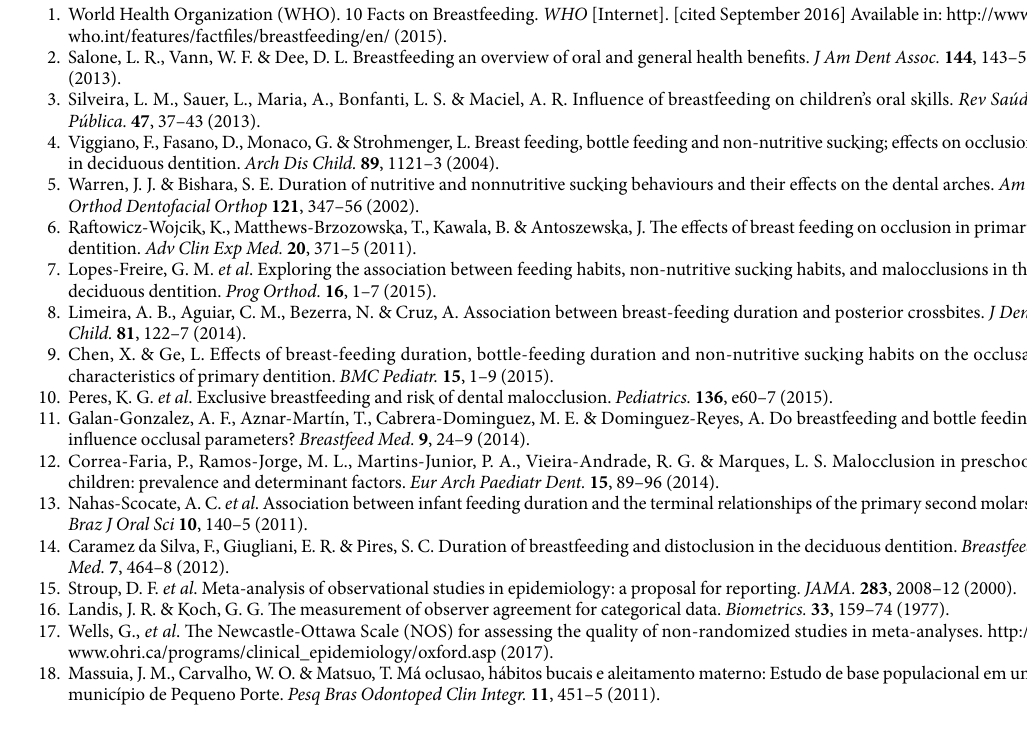
Almost all the studies collected the breastfeeding data through retrospective questionnaires or interviews with the parents, which could give rise to memory bias in the parents’ recollection of the number of months for which the children were breastfed. Only the 3 longitudinal studies 5, 10, 28 avoided this possible bias, collecting the data prospectively. Some limitations of the present systematic review and meta-analysis are that most of the studies did not spec- ify whether or not breastfeeding was exclusive, or take into account possible confounders such as digit sucking or the use of a pacifier. In an attempt to control for publication bias, the search was conducted in three databases and was comple- mented by a grey literature search and hand-searching. A further limitation in this meta-analysis is a certain heterogeneity among the studies analyzed, which limited their comparability. Additionally, they were observational studies of child populations, in which it is difficult to control for confounders. Although two systematic reviews 39, 40 and three meta-analyses 38, 41, 42 have been published recently, the present study provides separate assessments of the effects of breastfeeding on primary dentition and on mixed dentition, as well as a meta-analysis that examines the relations between breastfeeding and different malocclusion traits separately, including openbite, class II malocclusion and non-spaced dentition, which have not been studied in previous meta-analyses. In conclusion, breastfeeding is a protective factor against posterior crossbite and class II malocclusion in pri- mary and mixed dentition. The protective effect increases in line with the months of breastfeeding. There is no clear evidence for breastfeeding providing protection against other malocclusion risks such as openbite. To avoid bias in the results would require longitudinal studies with data on the months of exclusive breastfeed- ing, collected prospectively through questionnaires administered to the mothers, and subsequent examination of occlusal status at the primary dentition, mixed dentition and permanent dentition stages. They should also consider confounders such as non-nutritional sucking habits and the use of baby feeding bottles.